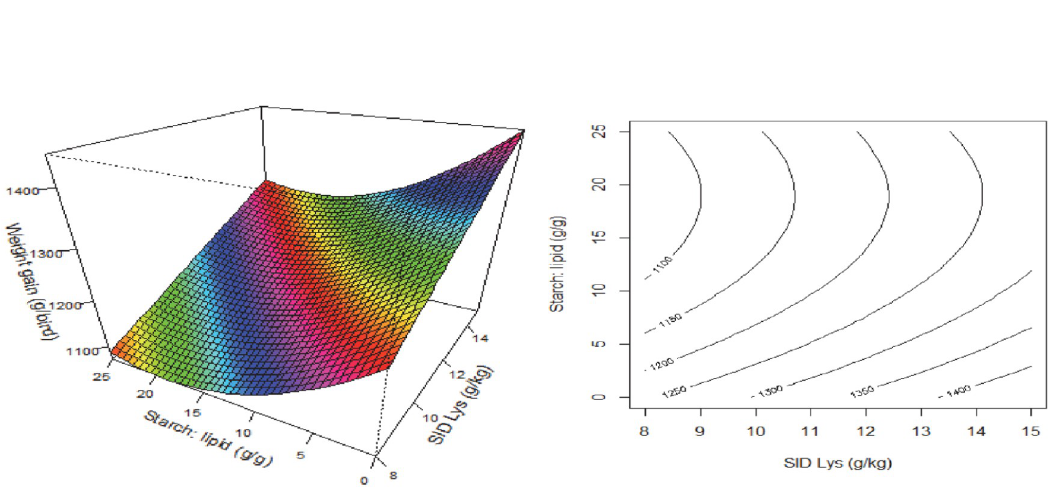
Fig 2. Response surface and contour plots describing relationships between weight gain (g/bird) and digestible lysine concentration (SID Lys) and starch to lipid ratios (S:L) in broiler chickens from 21–35 days post-hatch.